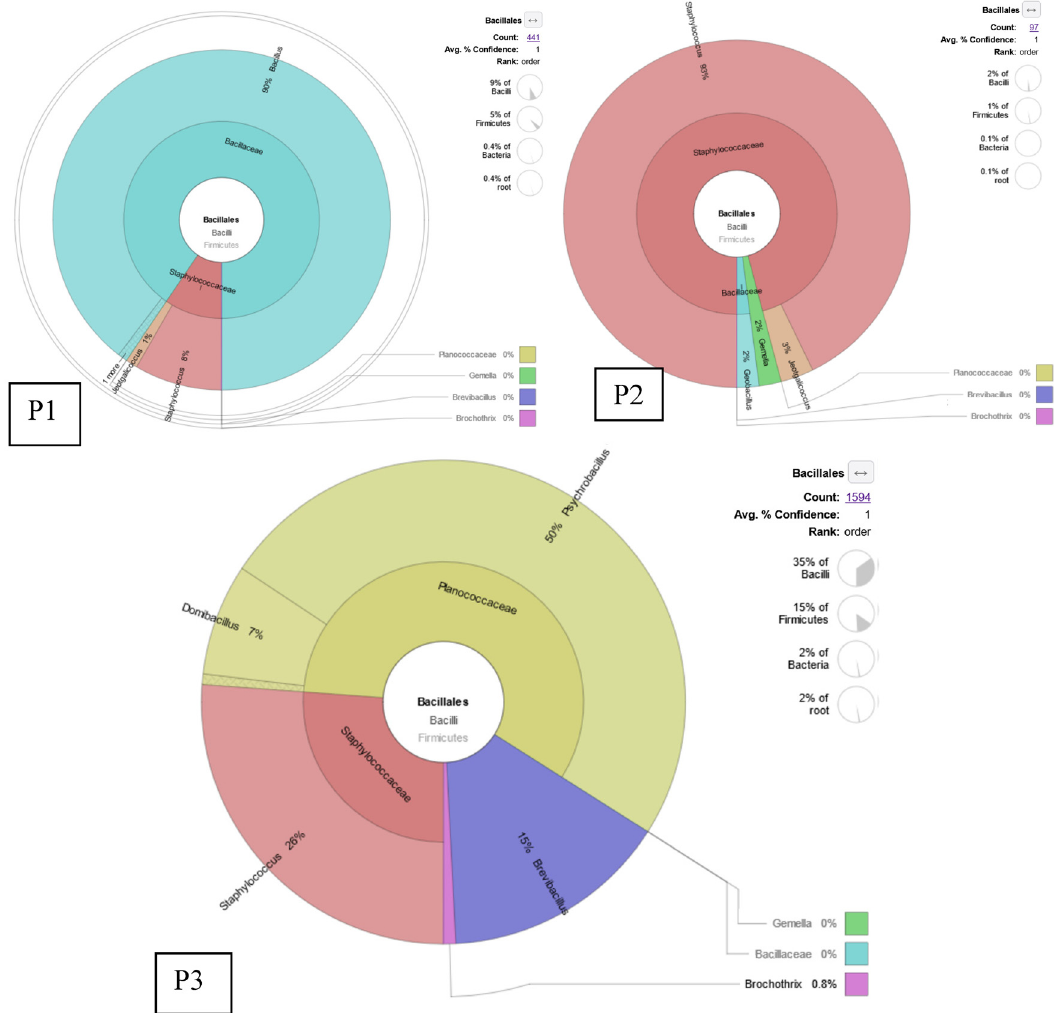
Figure 2: KRONA visually displays the analysis result of taxonomic annotation. Circles from inside to outside stand for di ff erent taxonomic ranks, and the area of the sector means a respective proportion of di ff erent OTU annotation results. The abundance of Bacillus spp. Were detected from the rearing water of commercial shrimp ponds. P1, P2, and P3 are ponds 1, 2, and 3,